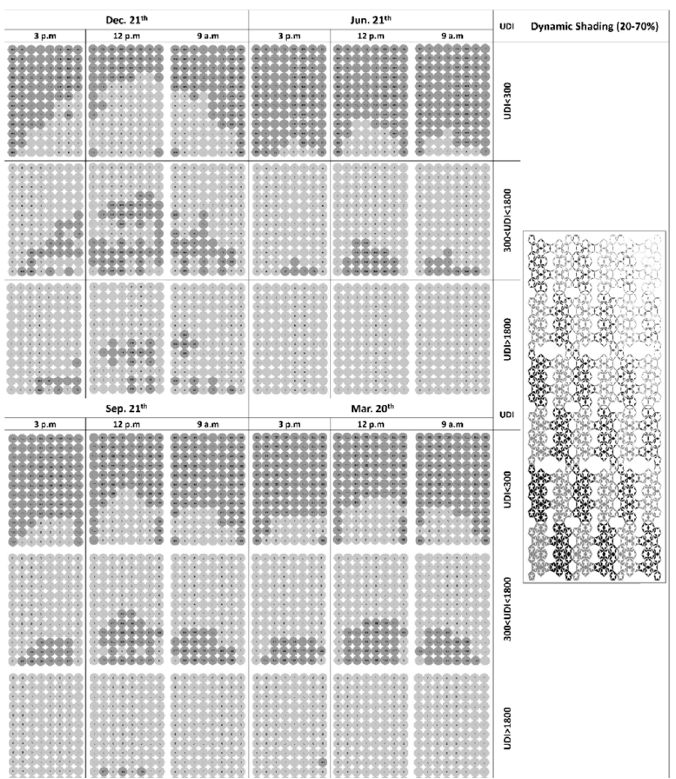
Figure 13. Useful Daylight Illuminance of critical days in the model with shading device type 3.